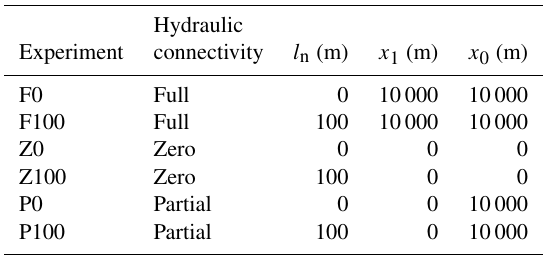
Table 2. Hydraulic connectivity along the ice–bed interface for ex- periments using the Schoof law. Water pressure is 100% of the full hydrostatic pressure (Eq. 7) downstream of position x 1 . Between x 1 and x 0 water pressure reduces linearly to 0%.